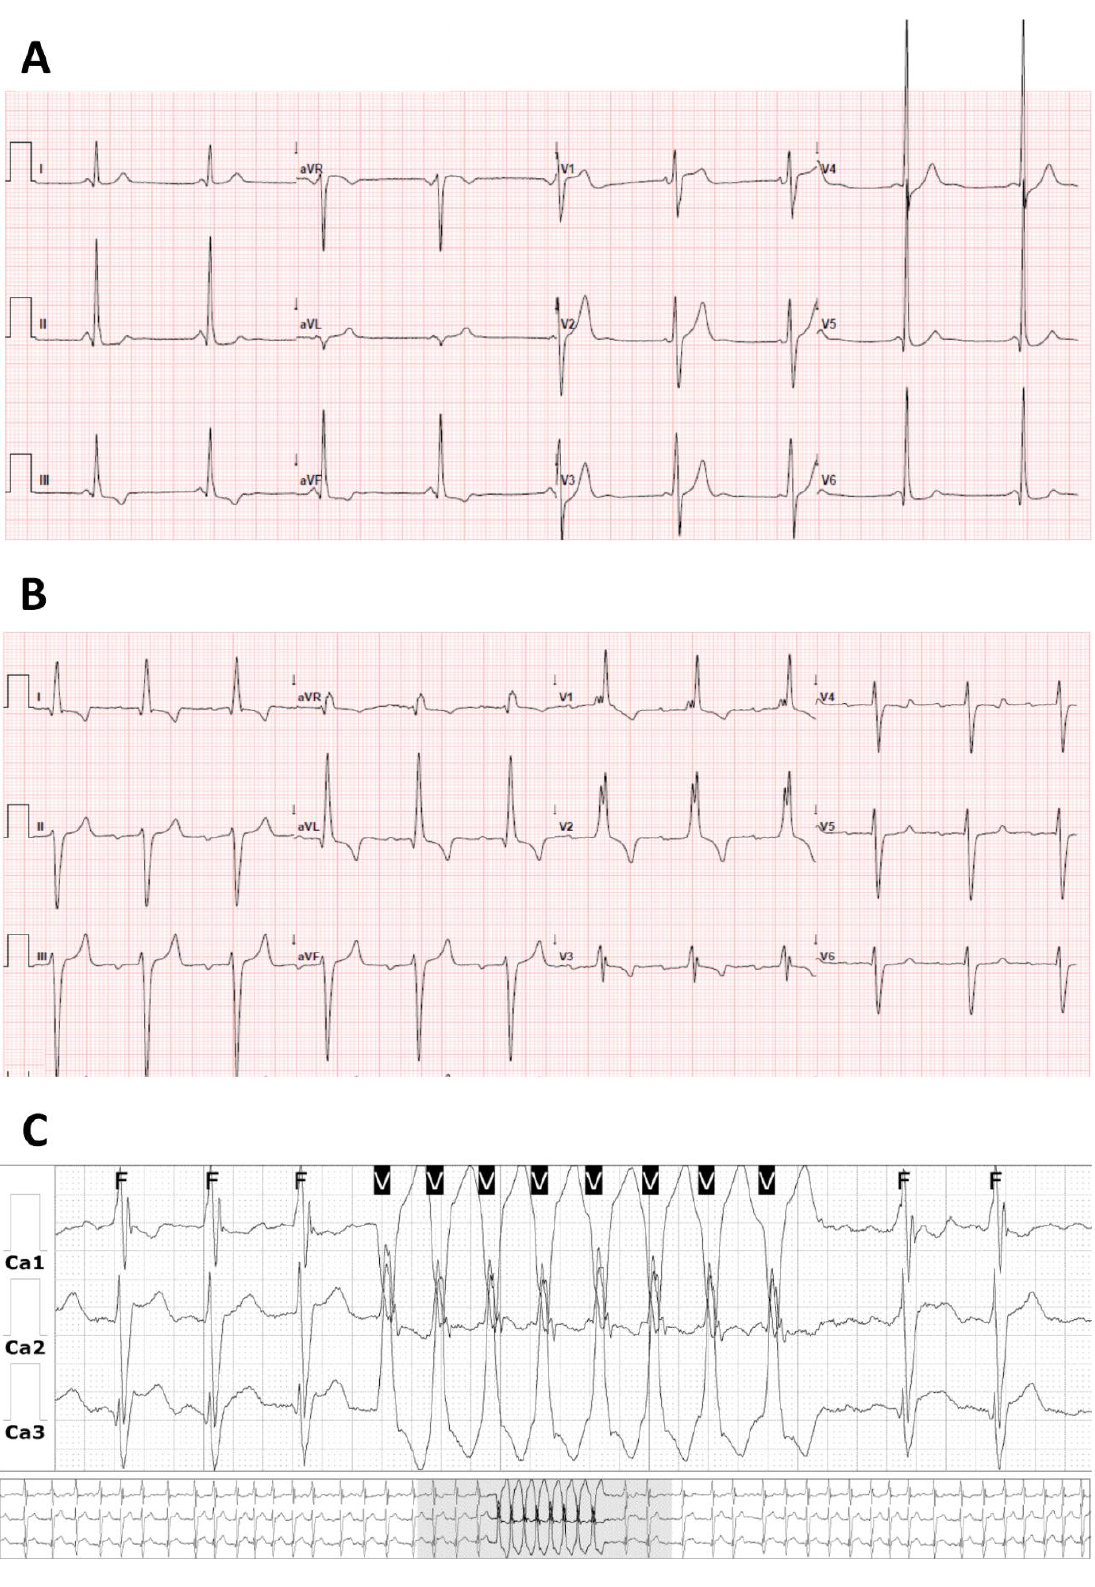
Figure 6. Electrocardiographic findings in FD. ( A ) Short PR interval in a 34-year-old male, ( B ) bifascicular and first-degree AV blocks and electrocardiographic criteria of LVH in a 72-year-old male, and ( C ) non-sustained VT in 24 h-Holter monitoring of a 76-year-old male. As FD progresses, GB3 accumulation and fibrosis lead to the development of AV and bundle-branch blocks [22,109,110] (Figure 6) and sinus node dysfunction [111], which may require a pacemaker. Bradycardia at rest is common (72%) [112]. Chronotropic incompe- tence with exercise due to autonomic nervous dysfunction may also occur and contribute